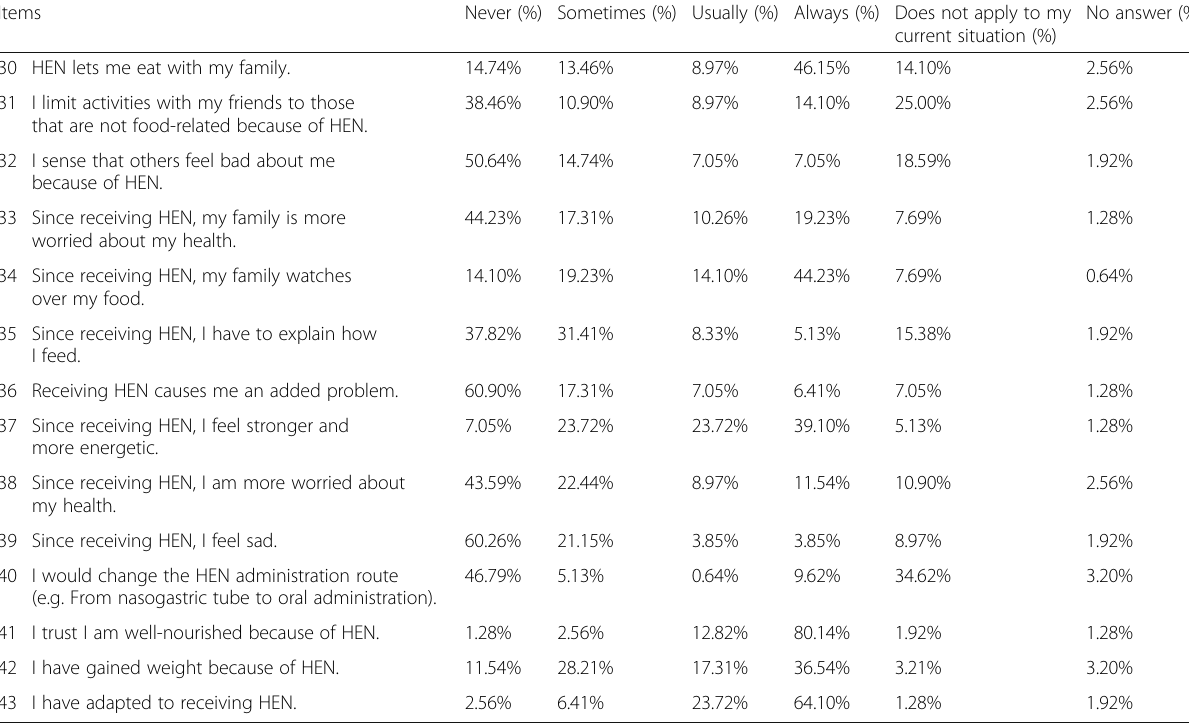
Table 3 Percentage of answers by category response in each item (Continued)